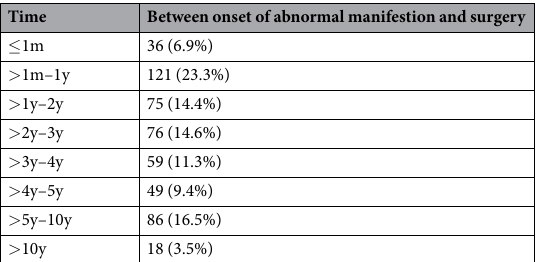
Table 2. Distribution of interval between initial identification of cataract-related manifestations and surgery in congenital/developmental cataract patients. Values are presented as n and percentage of all the congenital/ developmental patients reviewed in this study in the bracket. m = month; y =